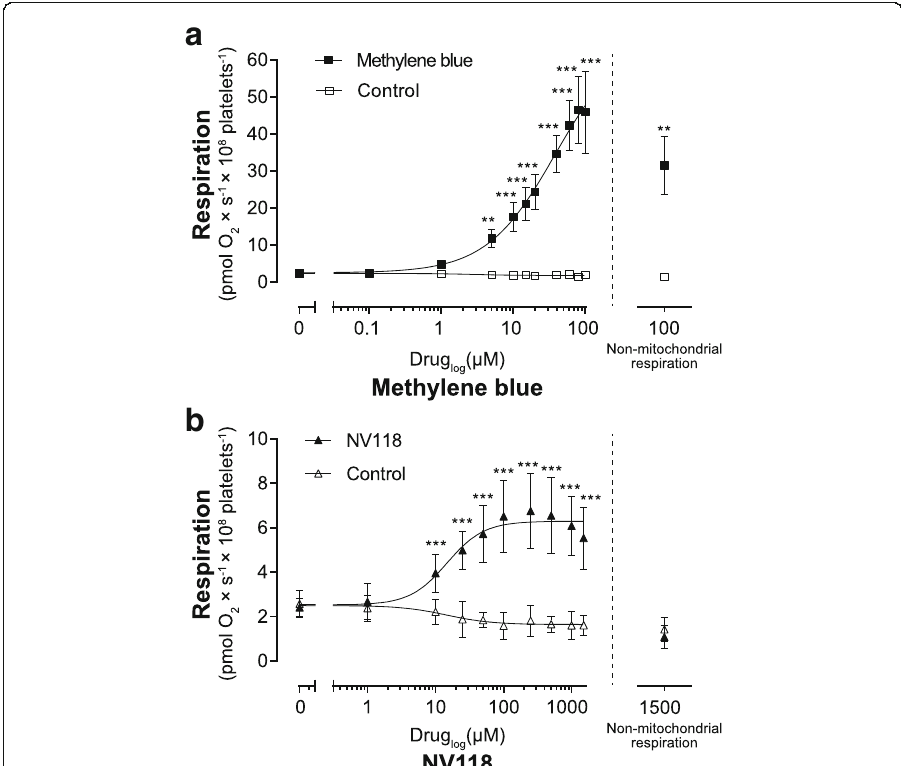
Fig. 1 Dose-response of methylene blue and NV118 on oxygen consumption in rotenone-intoxicated human platelets. Respiration was measured in human platelets with complex I inhibition induced by rotenone (2 μ M). The potential of the pharmacological bypass strategies methylene blue ( a black square) and the cell-permeable succinate prodrug NV118 ( b black triangle) to increase rotenone-inhibited respiration was evaluated by titrating increasing doses of drug or vehicle ( a white square, double-deionized water; b white triangle, DMSO). After maximal respiration was reached, the contribution of non-mitochondrial respiration to total respiration was evaluated by addition of the complex III inhibitor antimycin A (1 μ g/ml) followed by the complex IV inhibitor sodium azide (10 mM). The residual respiration shows the non-mitochondrial respiration at the highest dose of each drug. Data are expressed as mean±SD. Non-linear curve fitting was applied for generation of the dose- response curves. n =4. Two-way ANOVA with Bonferroni post hoc test was performed for analysis of differences. ** p <0.01, *** p <0.001, compared to vehicle